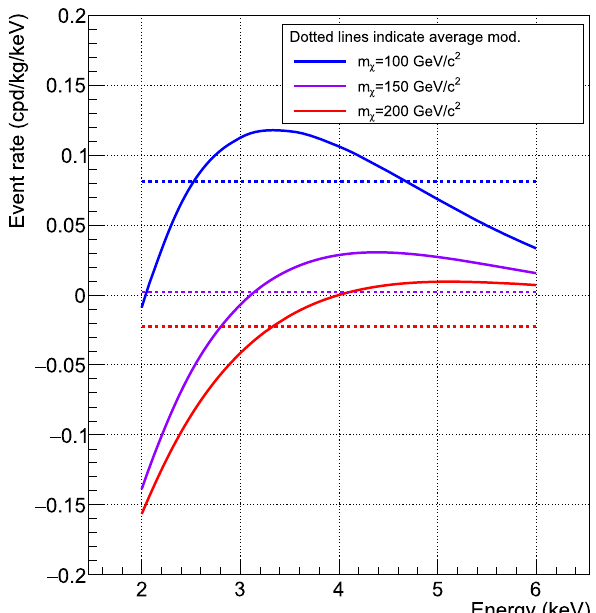
Fig. 6 Modulationratebothasaspectrumandaveragedovertheregion of interest for various DM masses and σ p = 2 . 5 − 40 cm